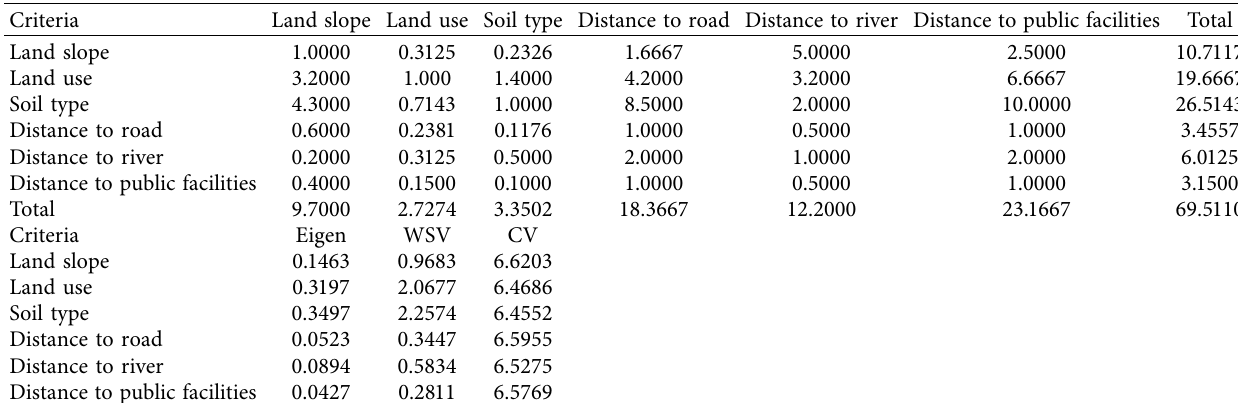
Figure 6: Entity-relationship diagram. Table 3: Normalization.